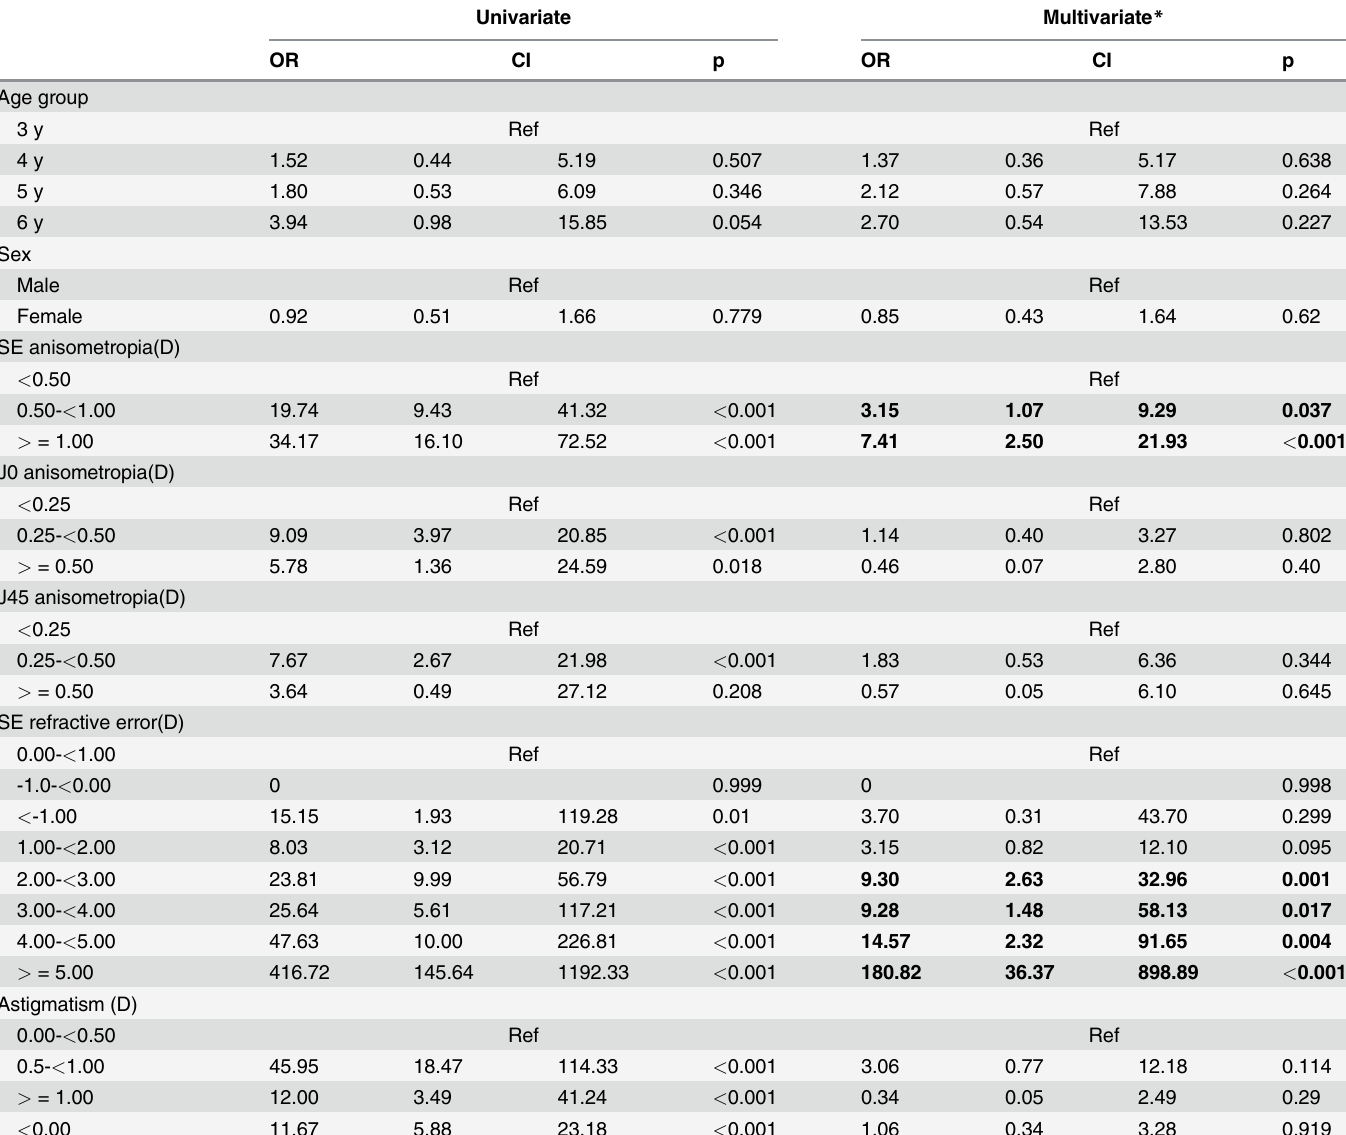
Table 2. Univariate and Multivariate Analyses for Associations between Refractive Error and Childhood Concomitant Esotropia. Univariate Multivariate *